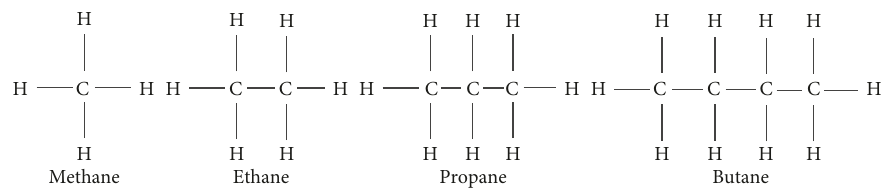
Figure 1: Straight chain of some alkanes.